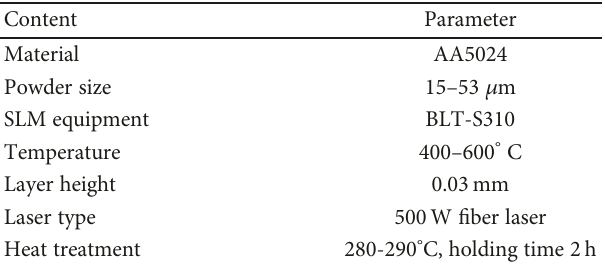
Table 1: Related introduction of selective laser melting (SLM) 3D printing.